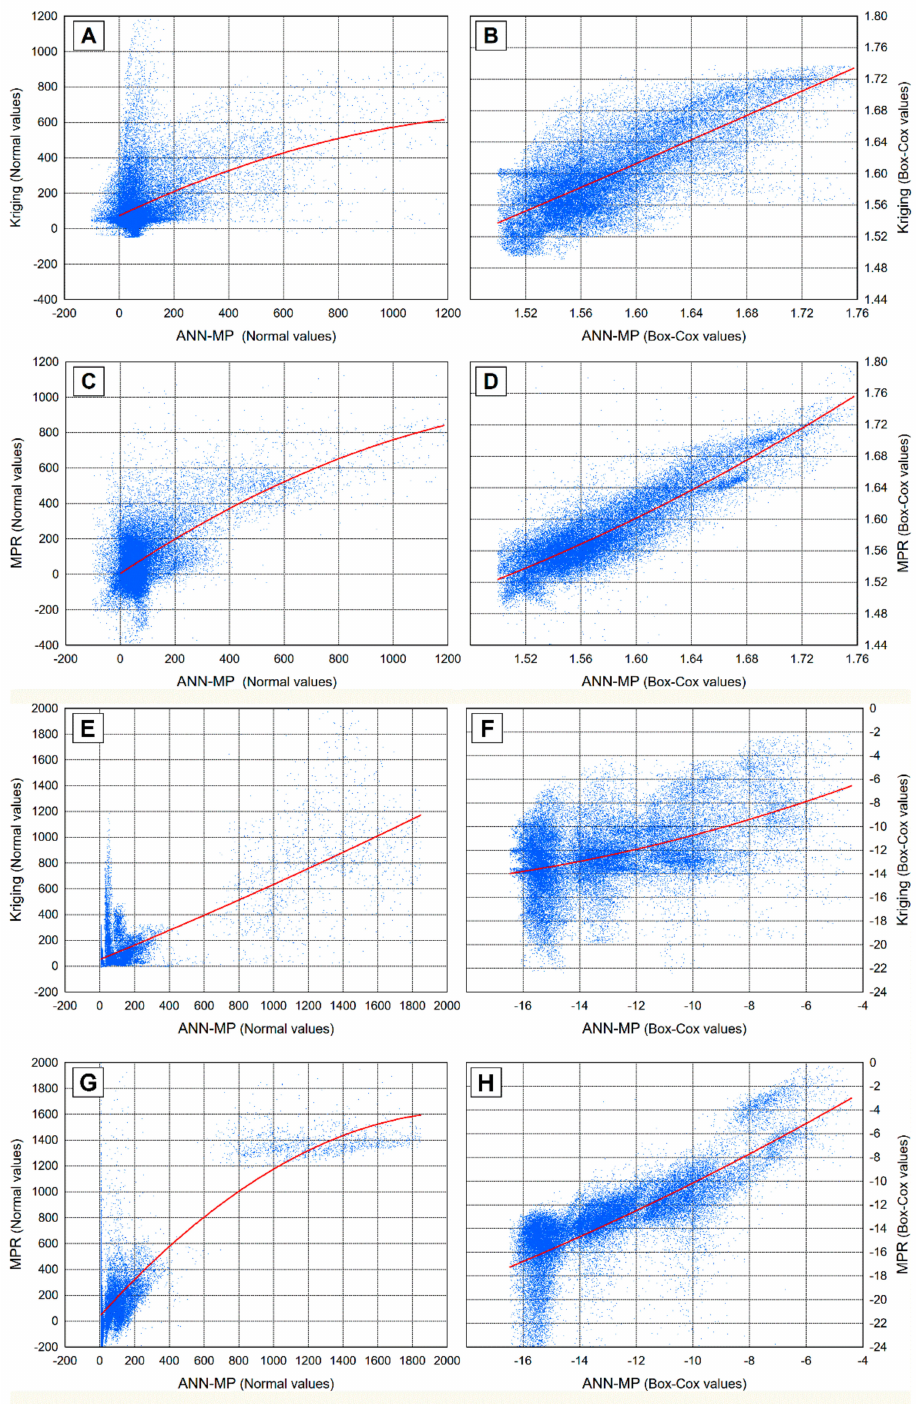
Figure 4. Regression plots between prediction methods: ANN-MP vs. Kriging ( A —Pb / Raw data values, B —Pb / Box-Cox values, E —Ti / Raw data values, F —Ti / Box-Cox values) and ANN-MP vs. MPR ( C —Pb / Raw data values, D —Pb / Box-Cox values, G —Ti / Raw data values, H —Ti / Box-Cox